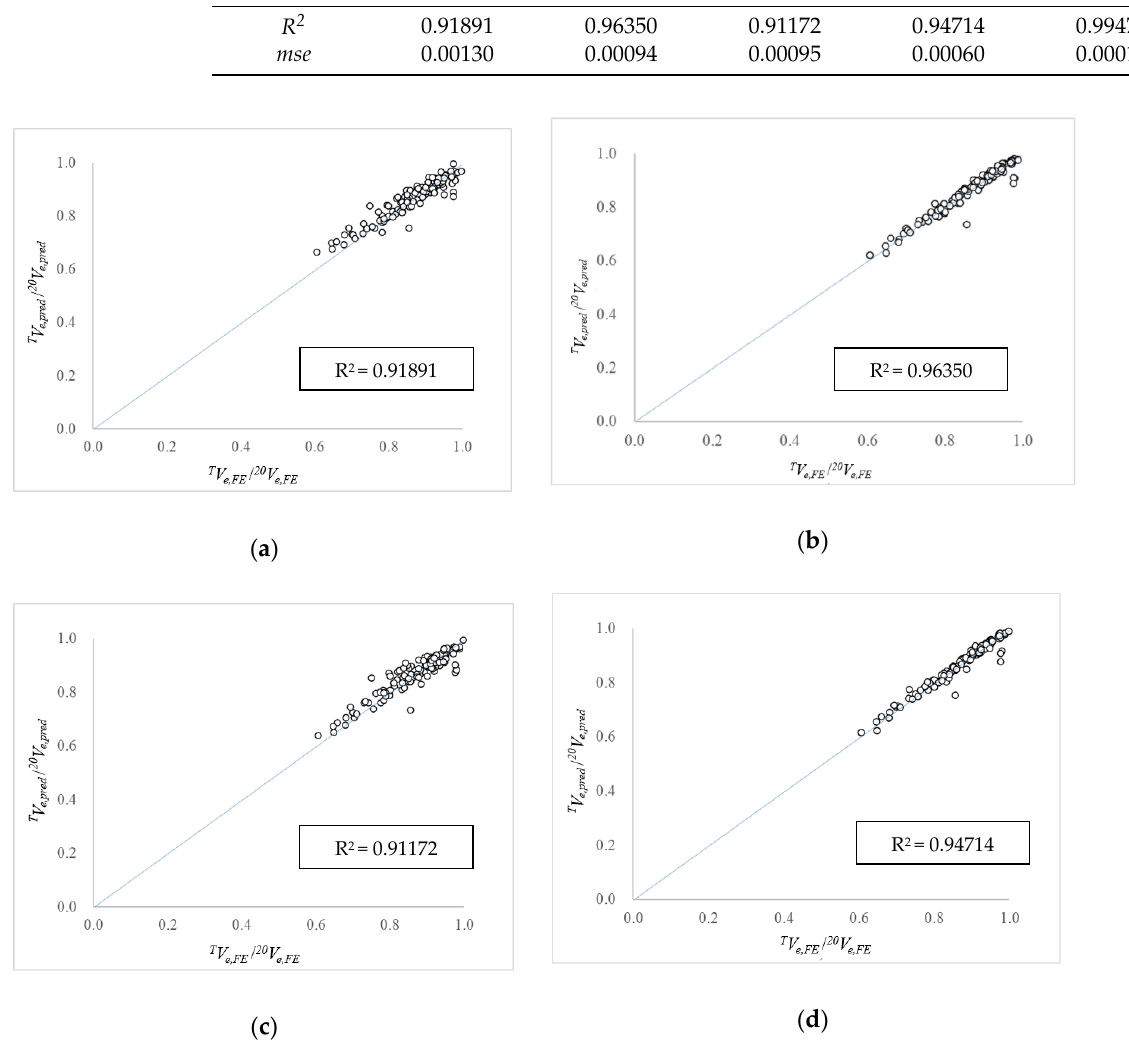
( e ) Figure 16. Training and test results of machine learning methodology for T V e / 20 V e . ( a ) T V e,pred / 20 V e,pred − T V e,FE / 20 V e,FE scatter plot of ANN_BP; ( b ) T V e,pred / 20 V e,pred − T V e,FE / 20 V e,FE scatter plot of ANN_RBF; ( c ) T V e,pred / 20 V e,pred − T V e,FE / 20 V e,FE scatter plot of SVR+CV; ( d ) T V e,pred / 20 V e,pred − T V e,FE / 20 V e,FE scatter plot of SVR+PSO; ( e ) T V e,pred / 20 V e,pred − T V e,FE / 20 V e,FE scatter plot of SVR+GA.